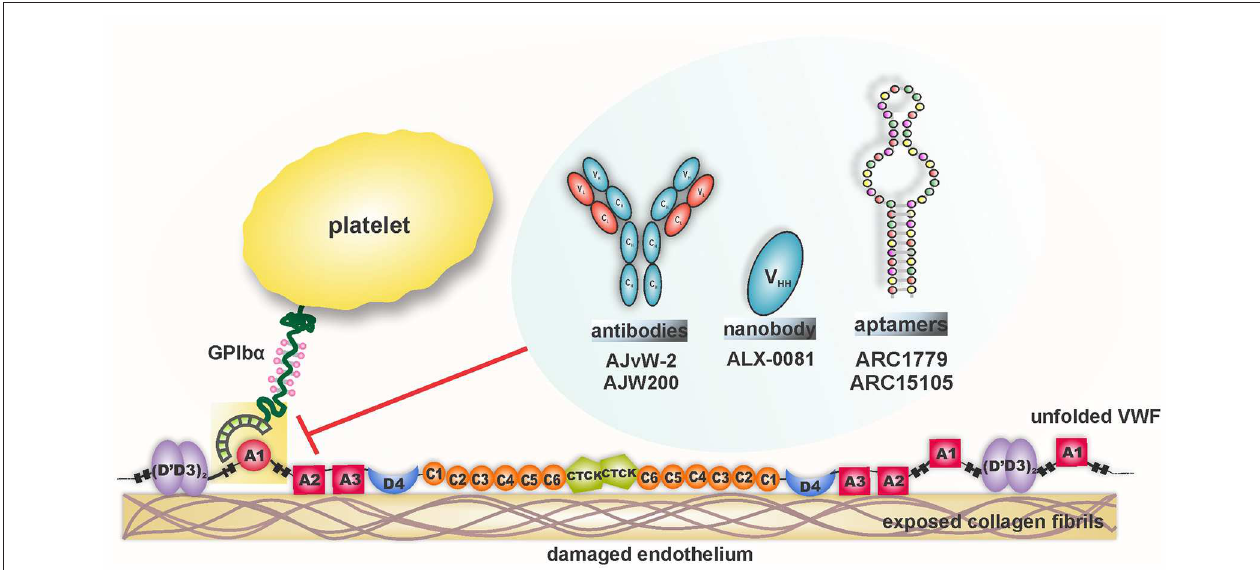
FIGURE 5 | Therapeutics targeting and inhibition of shear-driven VWF A1-GPIb